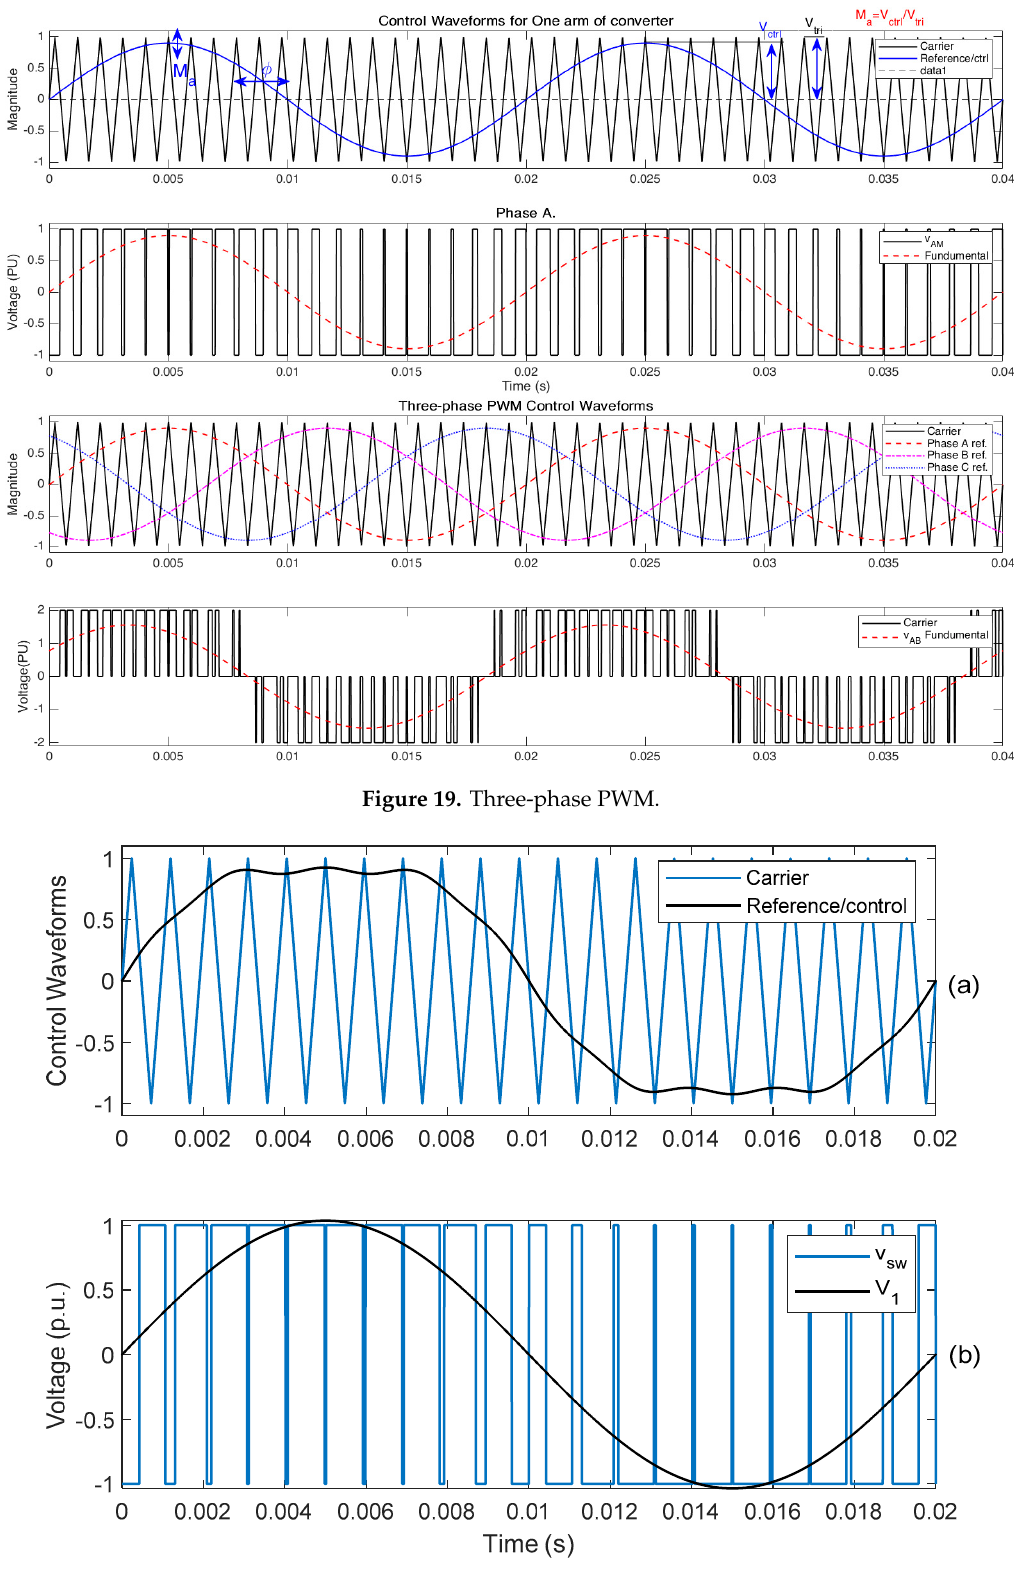
Figure 20. PWM with 3rd and 9th Harmonic: ( a ) Control Waveforms; ( b ) Synthesized Voltage waveform (V sw ) and its fundamental component (V 1 ).